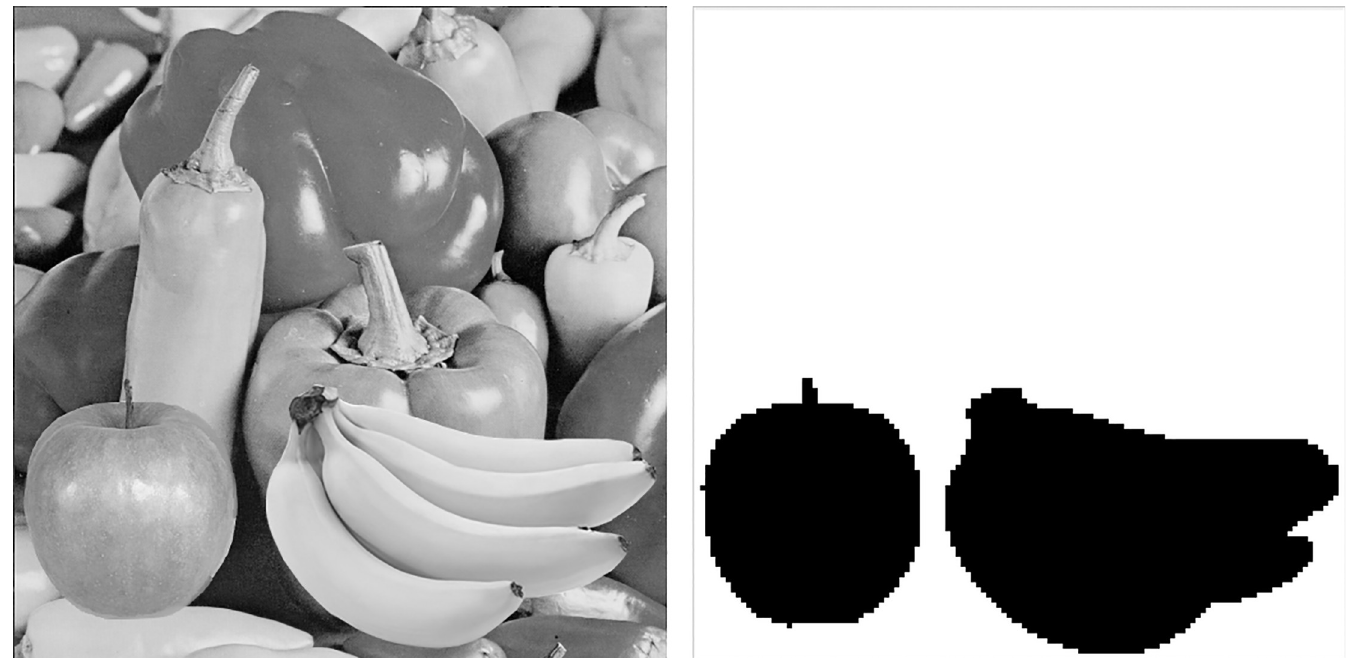
Fig 10. Tampered peppers image and tampered regions. (a) Tampered image. (b) Tampered Regions.